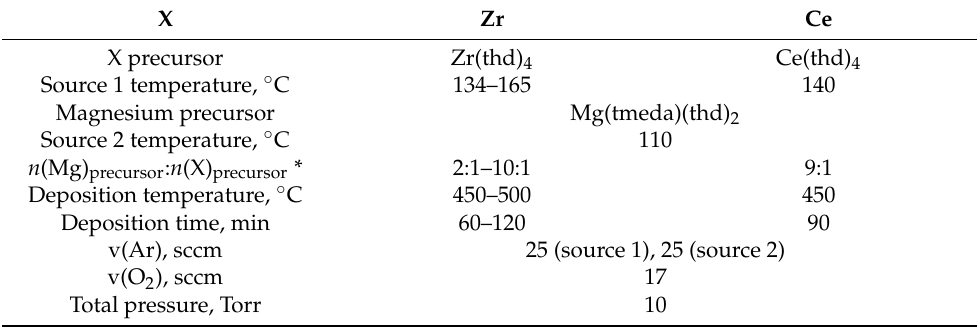
Table 1. MOCVD experimental conditions to prepare Mg–X–O mixed films (X = Zr, Ce). X